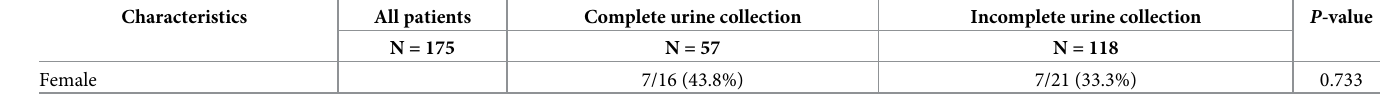
Values in table are presented as the mean ± standard deviation, or frequency (percentage) for categorical variables. The proportions are presented as percentages for categorical variables. a 52 of the 57 patients had computed tomography scan image results. Abbreviations: LC, liver cirrhosis, AIH, autoimmune hepatitis, MELD, model for endstage liver disease, AST, aspartate aminotransferase, ALT, alanine aminotransferase, BUN, blood urea nitrogen, Cr, creatinine, Na, sodium, PT INR, prothrombin time international normalized ratio, PMTH, psoas muscle thickness per